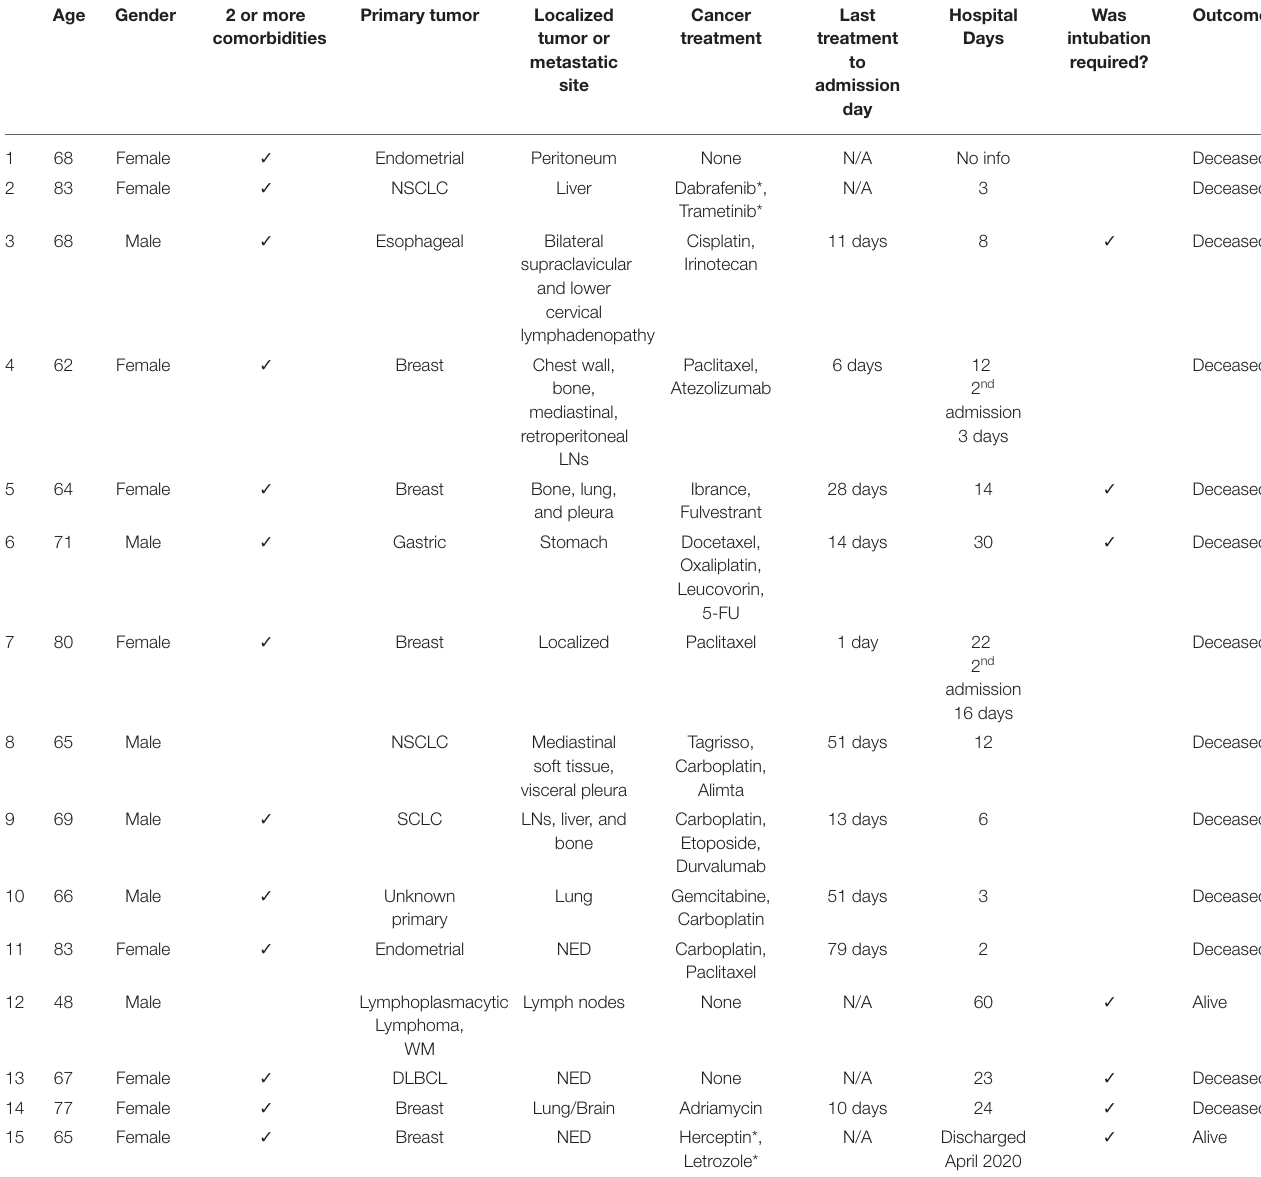
TABLE 3 | Clinical characteristics of patients in group B, hospitalized and diseased or requiring intubation. Age Gender